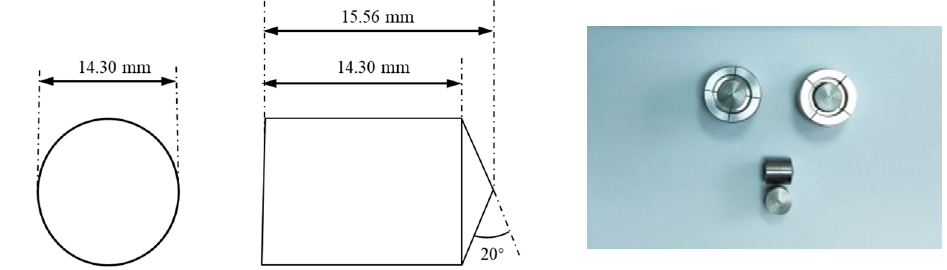
Figure 3. Size and shape of the experimental projectile.